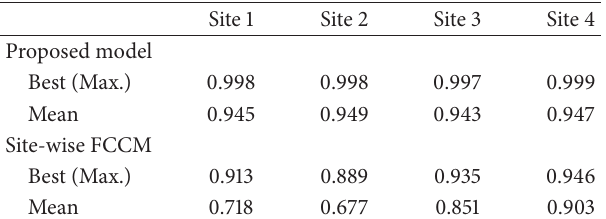
Table 1: Comparison of partition quality measured by correlation coefficients among item memberships (homogeneous partition case). Site